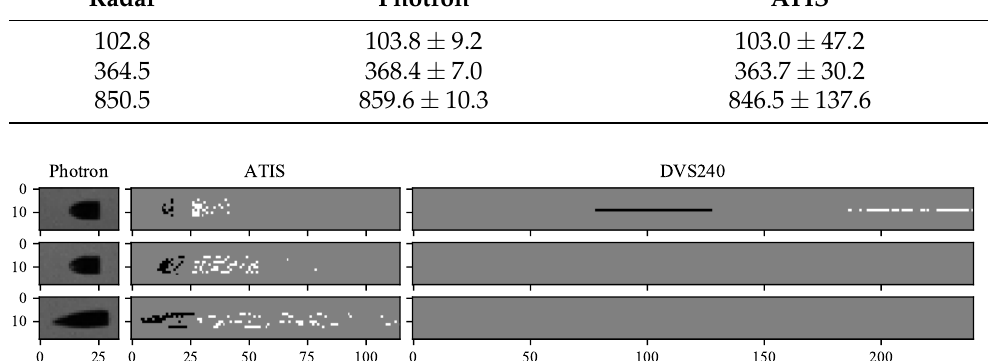
Figure 14. Sample images of the projectiles as seen by the Photron, ATIS, and DVS240 cameras. The event camera images display 10 µ s of events, white are positive and black are negative polarity. The Photron exposure time was 1 µ s. The projectile speed increased from top to bottom, from 100 through 365 to 850 m/s. (Image speed 87, 310 and 730 kpx/s.)